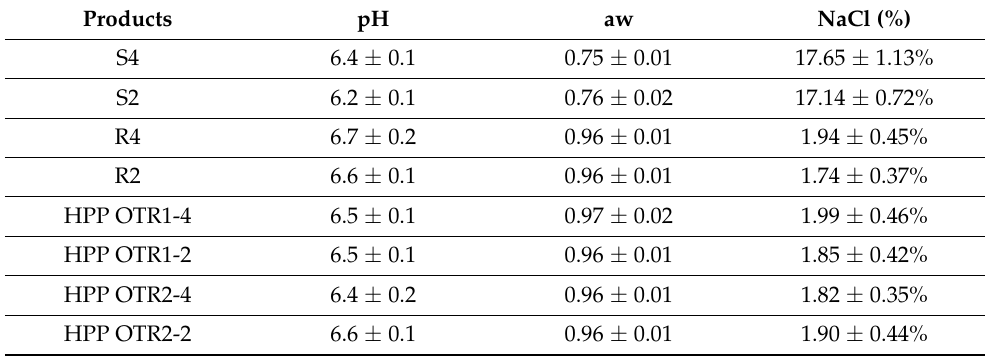
Table 4. pH, aw, and sodium chloride detection from differently processed cod products (average and standard